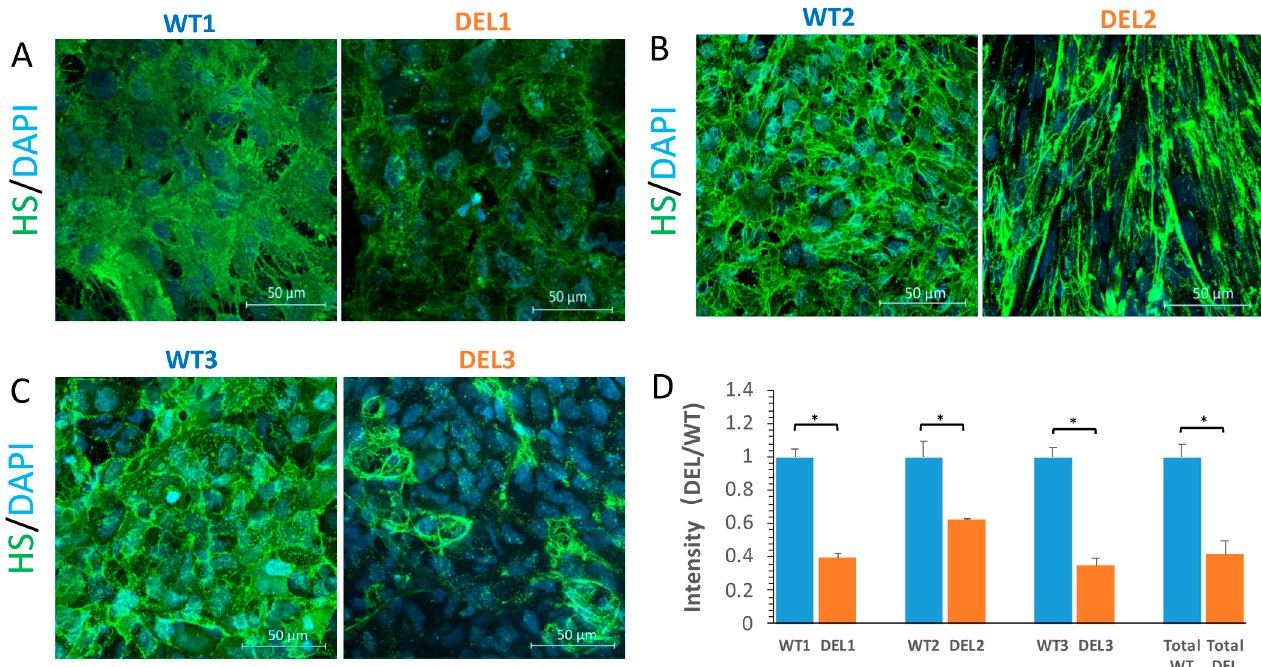
showing tight junction proteins (ZO-1 and occludin) at the iBBB for the control (left panel) and 22q11.2DS-SCZ (middle panel) from 3 paired iPSCs ( A – C ). The right panel shows the comparison of the normalized intensity profiles of ZO-1 and occludin labeling along a ~3 μ m line perpendicular to the EC junctions (white lines in the confocal images). n = 3 samples with 180–270 junctions (720–1080 perpendicular lines) analyzed for each case. * p < 0.05.